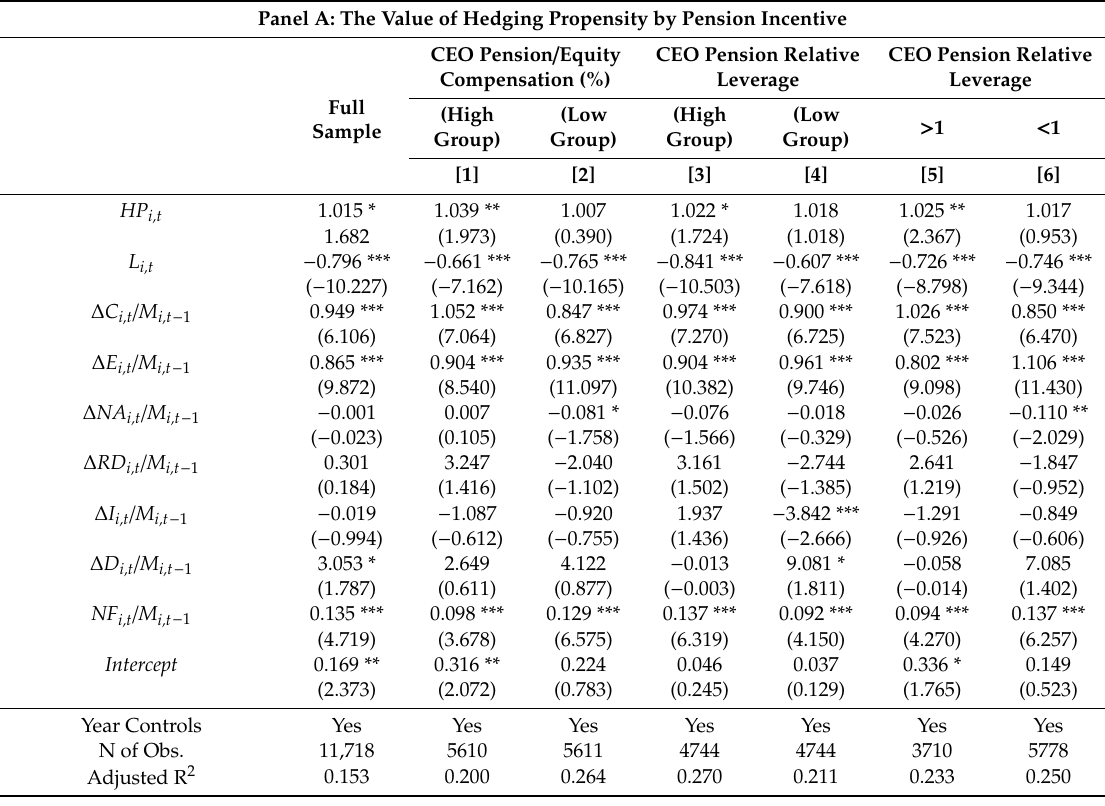
Table 8. The impact of pension incentives on the value of